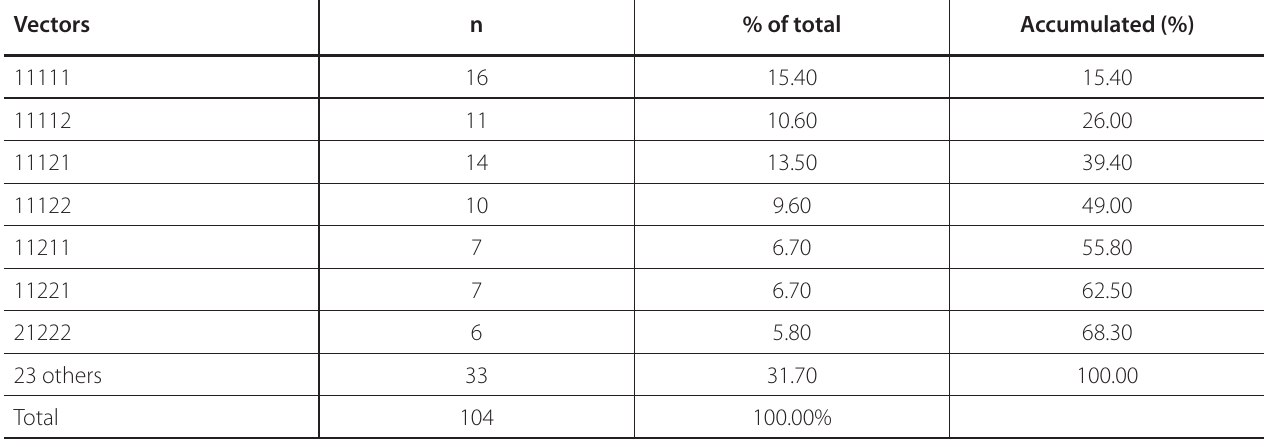
Table 3 . Frequency of EQ-5D health status of elderly patients with a